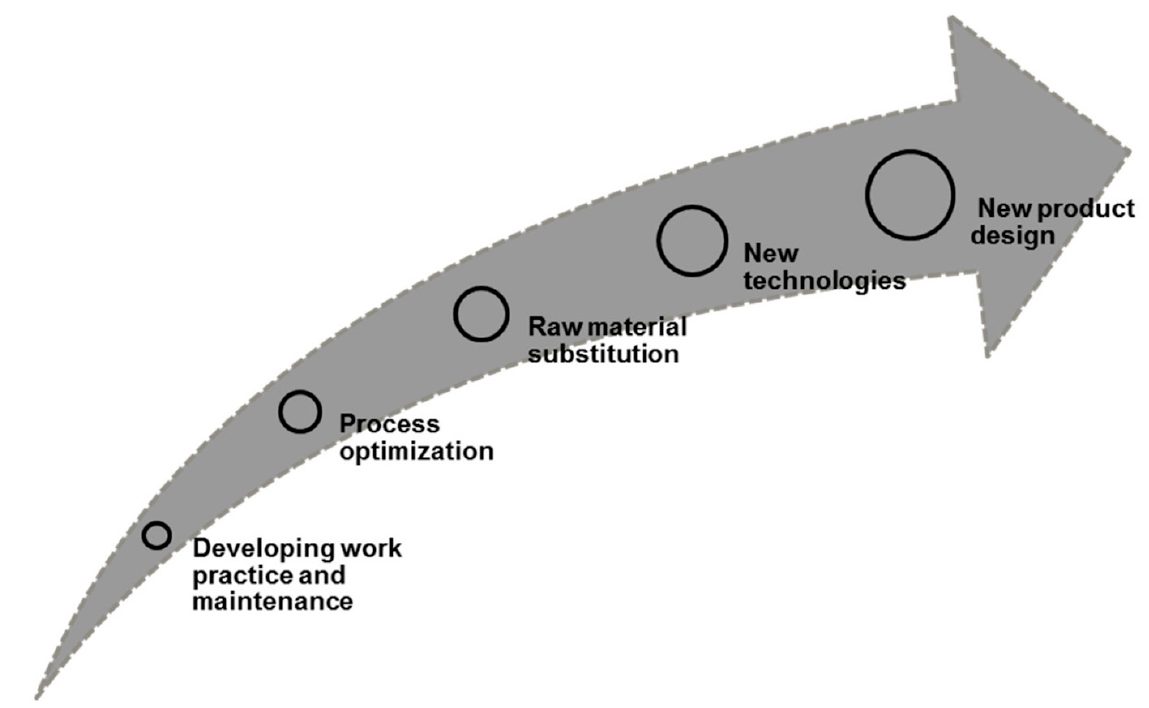
Figure 2. Implementation steps of sustainable design development. Adapted with permission from Ref. [66]. Copyright 2021 MDPI.